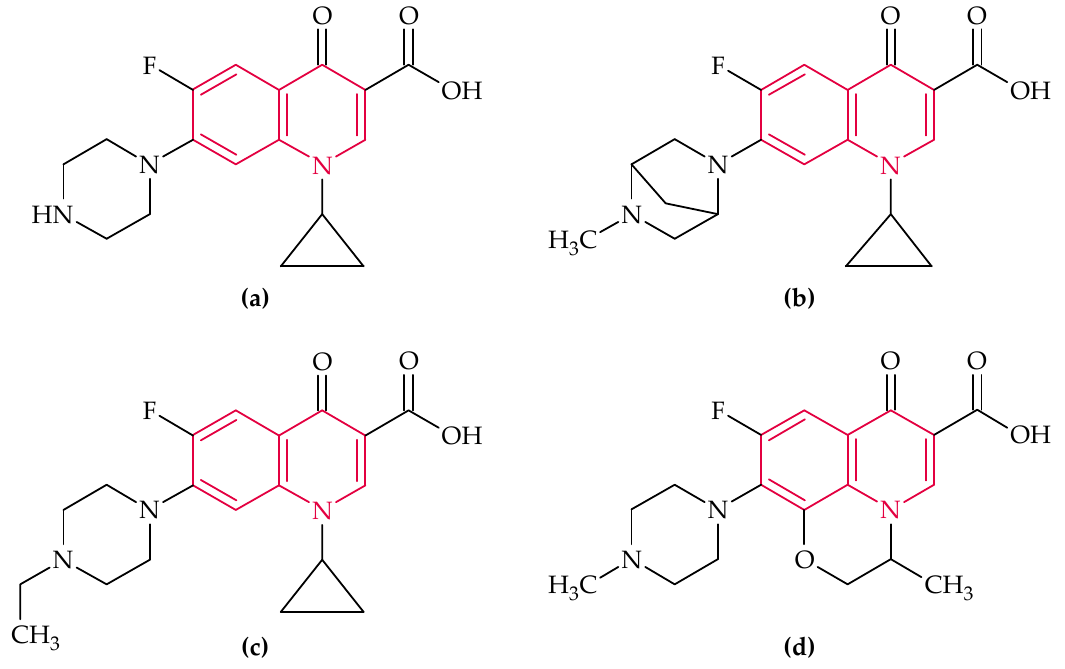
Figure 6. Chemical structure of: ( a ) ciprofloxacin; ( b ) danofloxacin; ( c ) enrofloxacin; and ( d ) ofloxacin. The structure of quinolone is marked in red.